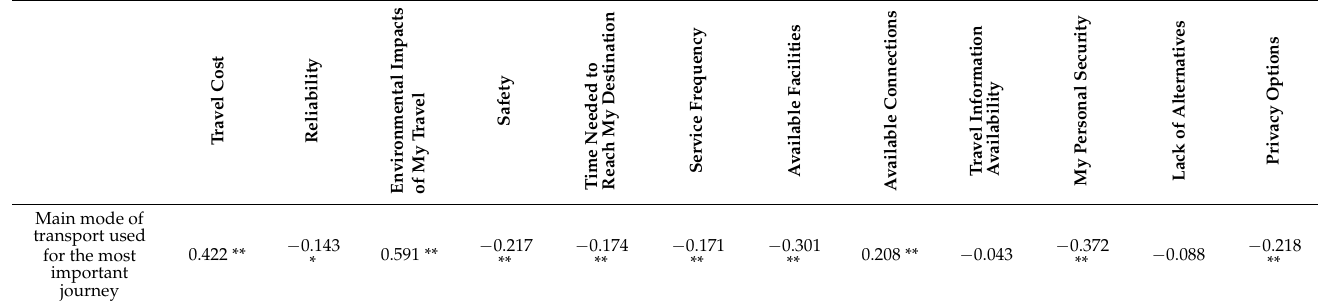
Table 5. Main mode of transportation used and its determinants (Source: Authors’ survey